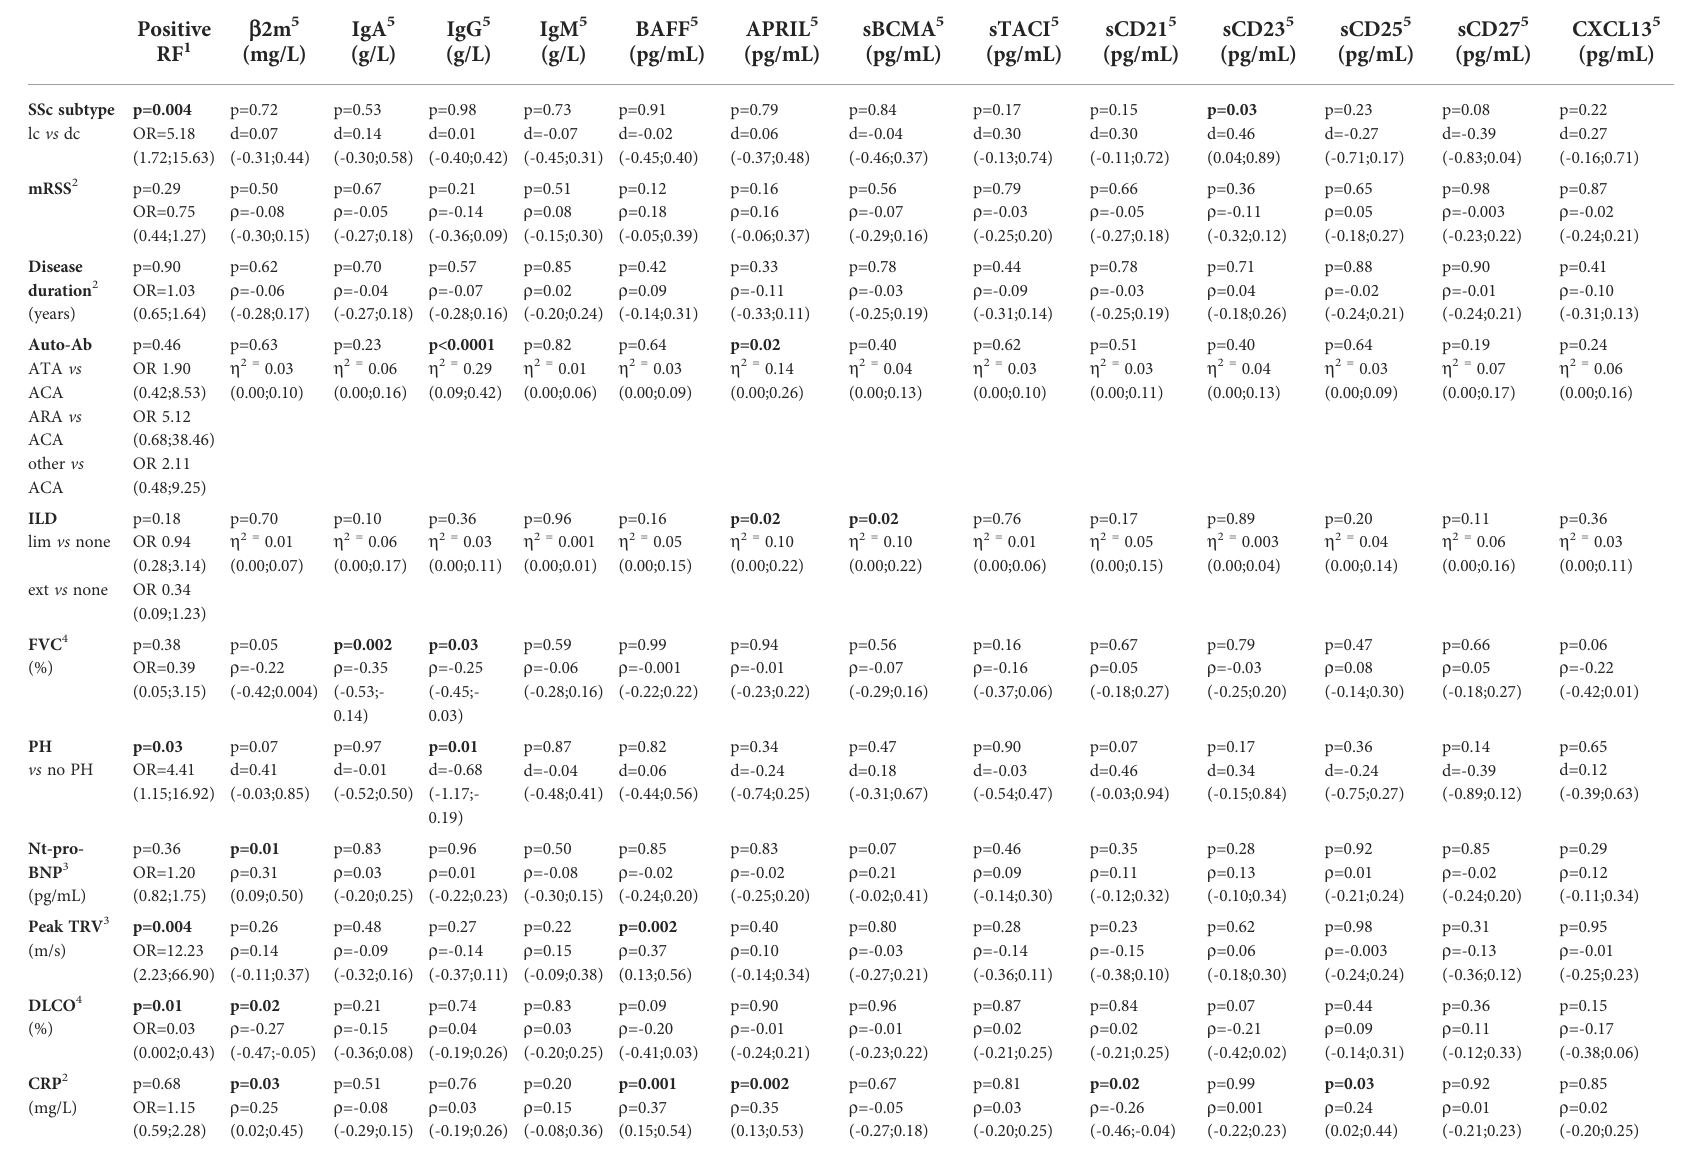
TABLE 3 Associations between serum levels of soluble markers of B cell activation and disease characteristics assessed among the 80 SSc patients from the discovery